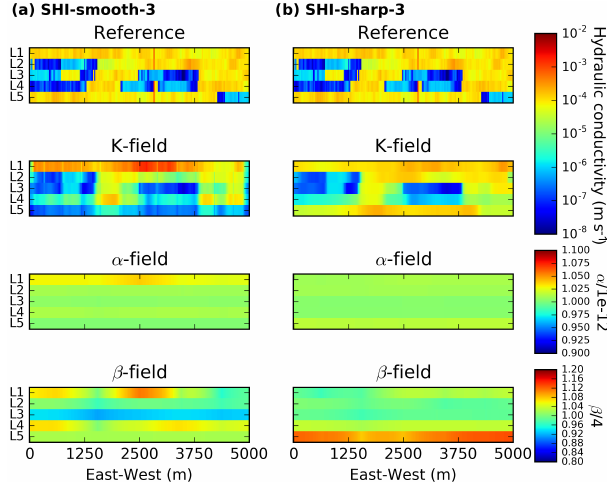
Figure 6. Measurement objective function value obtained for the various groundwater model calibration cases, while E [ (cid:56) m ] is the mean value across all 20 different system realizations. The dashed line indicates the expected target value for the model calibrations.